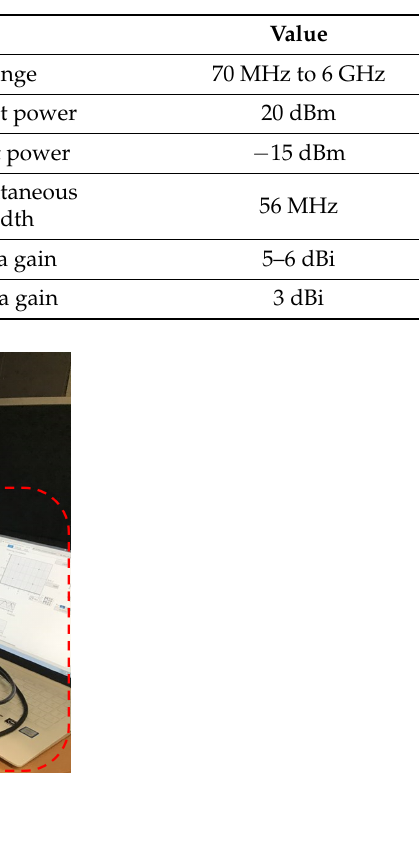
Table 1. RF specifications of the software defined radio (SDR) device and the antennas.